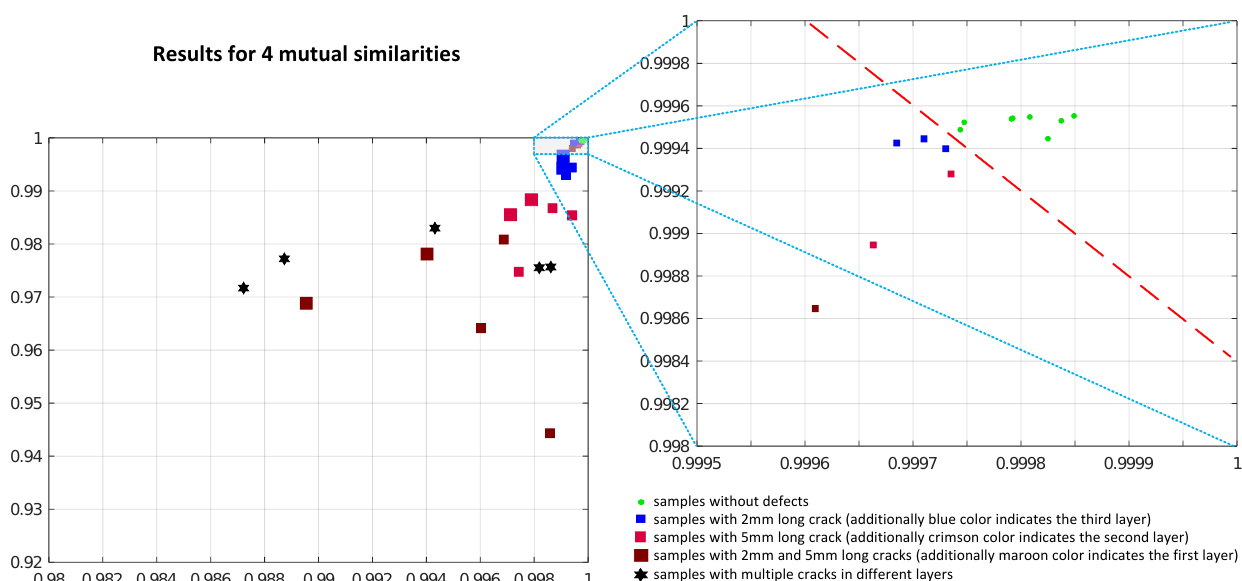
Figure 21. Results obtained applying four mutual comparisons employing the SSIM4 metric using the maximum and average of its values calculated for 17 images corresponding to various frequencies used in experiments.